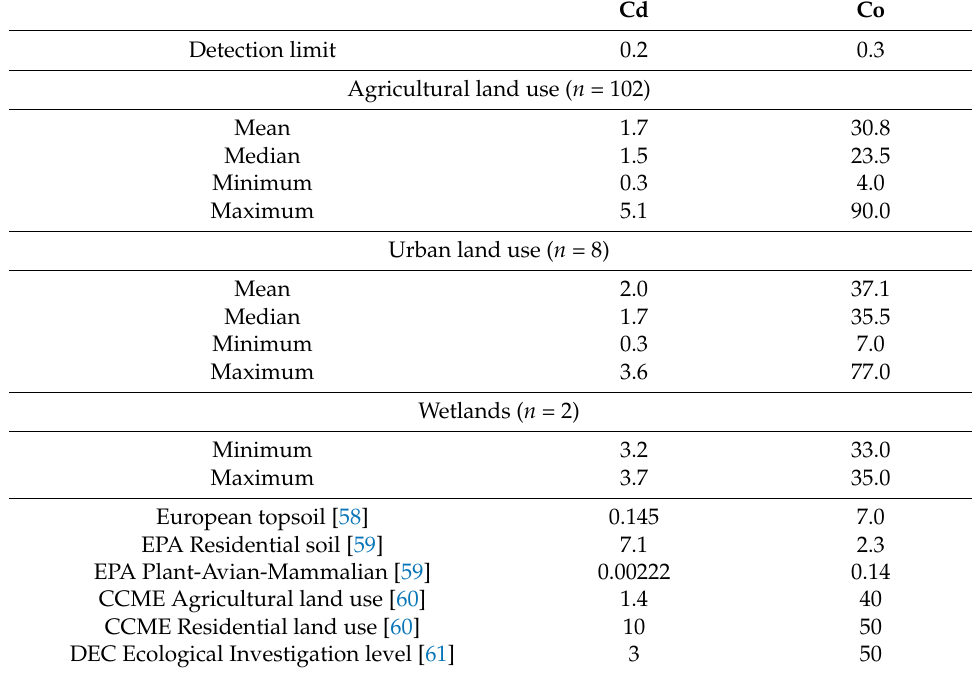
Table 1. Detection limits, descriptive statistics of Cd and Co concentration (in mg kg − 1 ) in soil gathered from the Ioannina plain, and criteria obtained from the